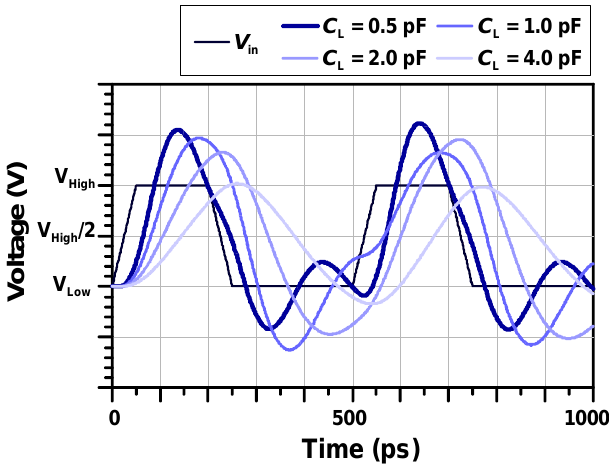
Figure 14: Transient responses versus load C L for case 2.